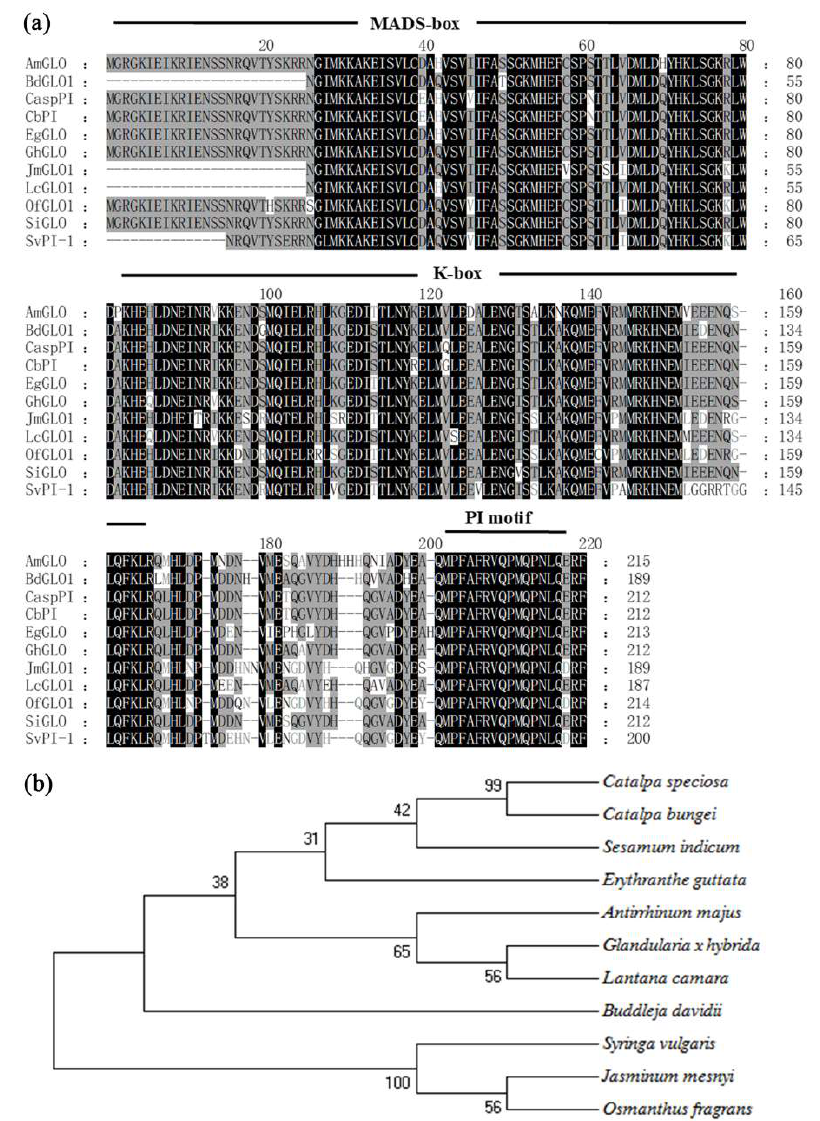
Figure 2. Sequence alignment and phylogenetic analysis of GLO homologs among different species. ( a ) Multiple alignment of amino acids. ( b ) Phylogenetic analysis. Completely identical amino acids are indicated with white letters against a black background; conservative amino acids are indicated with black letters against a grey background; the partly similar and non-similar amino acids are indicated by grey letters and black letters on a white background, respectively. The MADS-box, K-box, and PI motif are indicated by lines. The phylogenetic tree was constructed using the Neighbor-Joining method in MEGA6.6. The amino acid sequences were aligned as follows: AmGLO ( Antirrhinum majus , Q03378); BdGLO1 ( Buddleja davidii , AEM60219); CaspPI ( Catalpa speciosa , AMB20847); CbPI ( Catalpa bungee , AJY60427); EgGLO ( Erythranthe guttata , XP_012855839); GhGLO ( Glandularia x hybrid , BAE72882); JmGLO1 ( Jasminum mesnyi , AEM60214); LcGLO1 ( Lantana camara , AEM60216);